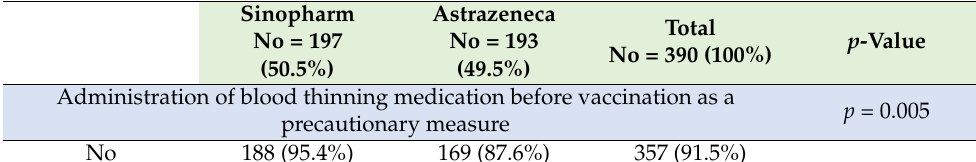
Table 4. Comparison between the Sinopharm and Astrazeneca vaccines’ common side effects.